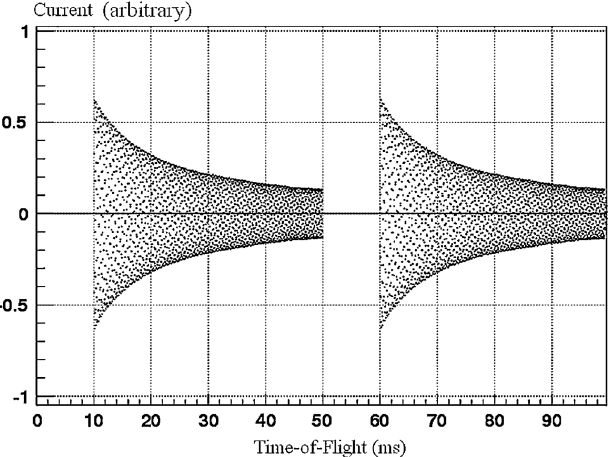
solenoid (left) and for the resistive dummy load (right) as measured by ADC. The signals were sampled at the rate of 62.6 kHz over 40-ms long neutron frame. Note that the signals (cid:4) 0 ms but data acquisition starts at 10 start at t tof